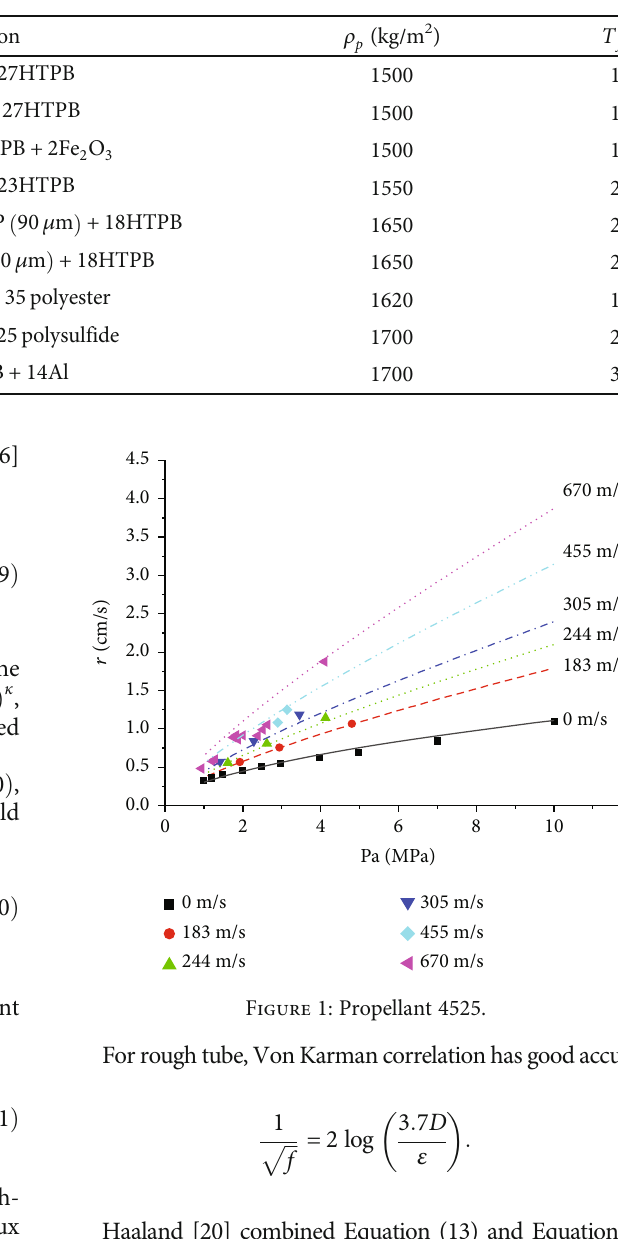
Table 1: Propellant parameters.